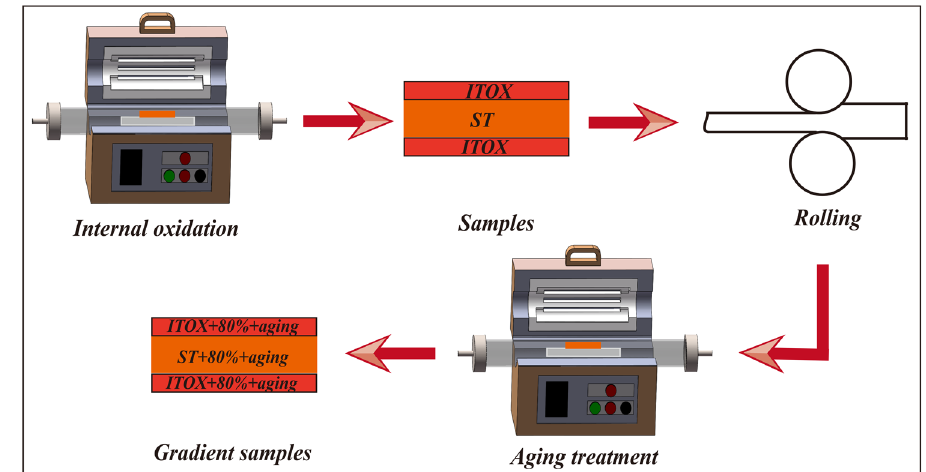
Figure 1: The process fl ow of the Cu – Cr – Ti